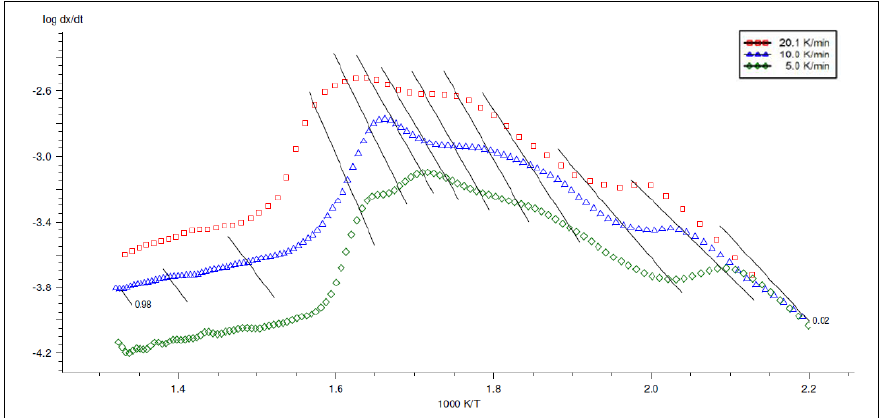
oat straw sample.